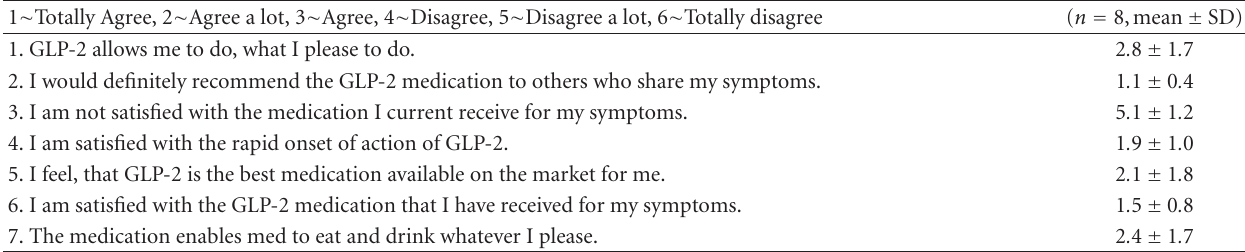
Table 5: Evaluation of treatment